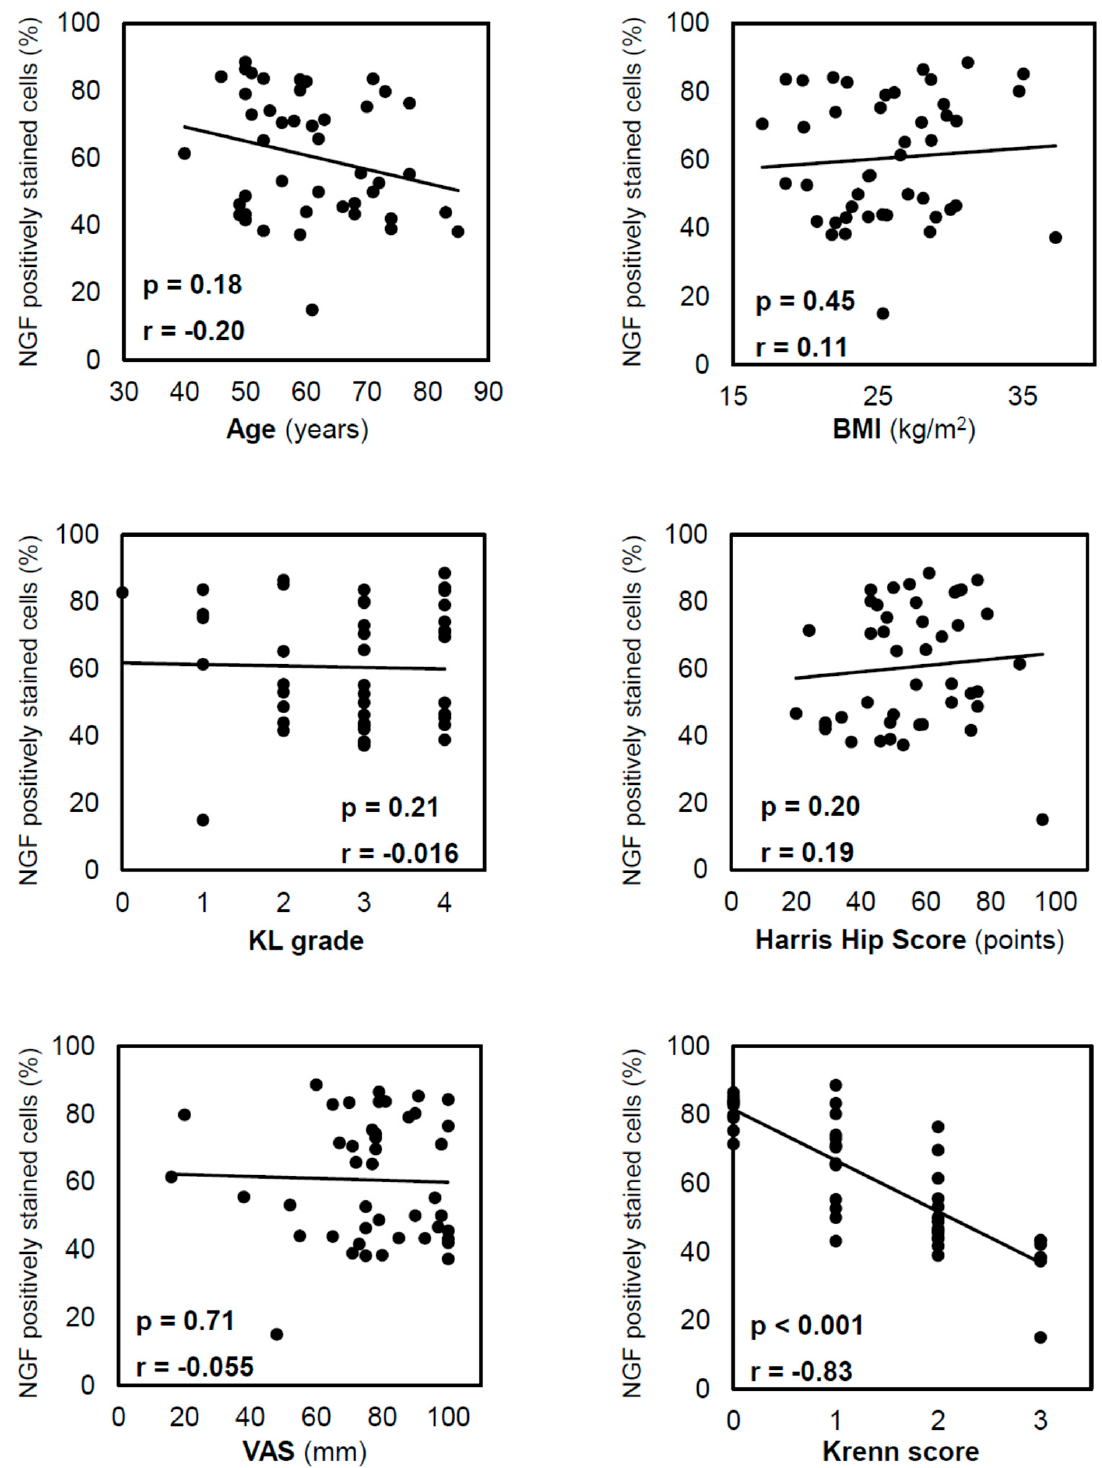
Figure 4. Correlation between NGF-positive staining in cells in the inner region and other variables. Correlations were analysed using Spearman’s correlation coefficient. NGF expression decreased with the progression of acetabular labral degeneration, as reflected by the Krenn score. NGF, nerve growth factor; BMI, body mass index; KL, Kellgren–Lawrence; VAS, visual analogue scale. As similar correlations were observed in the inner and outer regions, the results discussed in the succeeding sections are focused on the inner